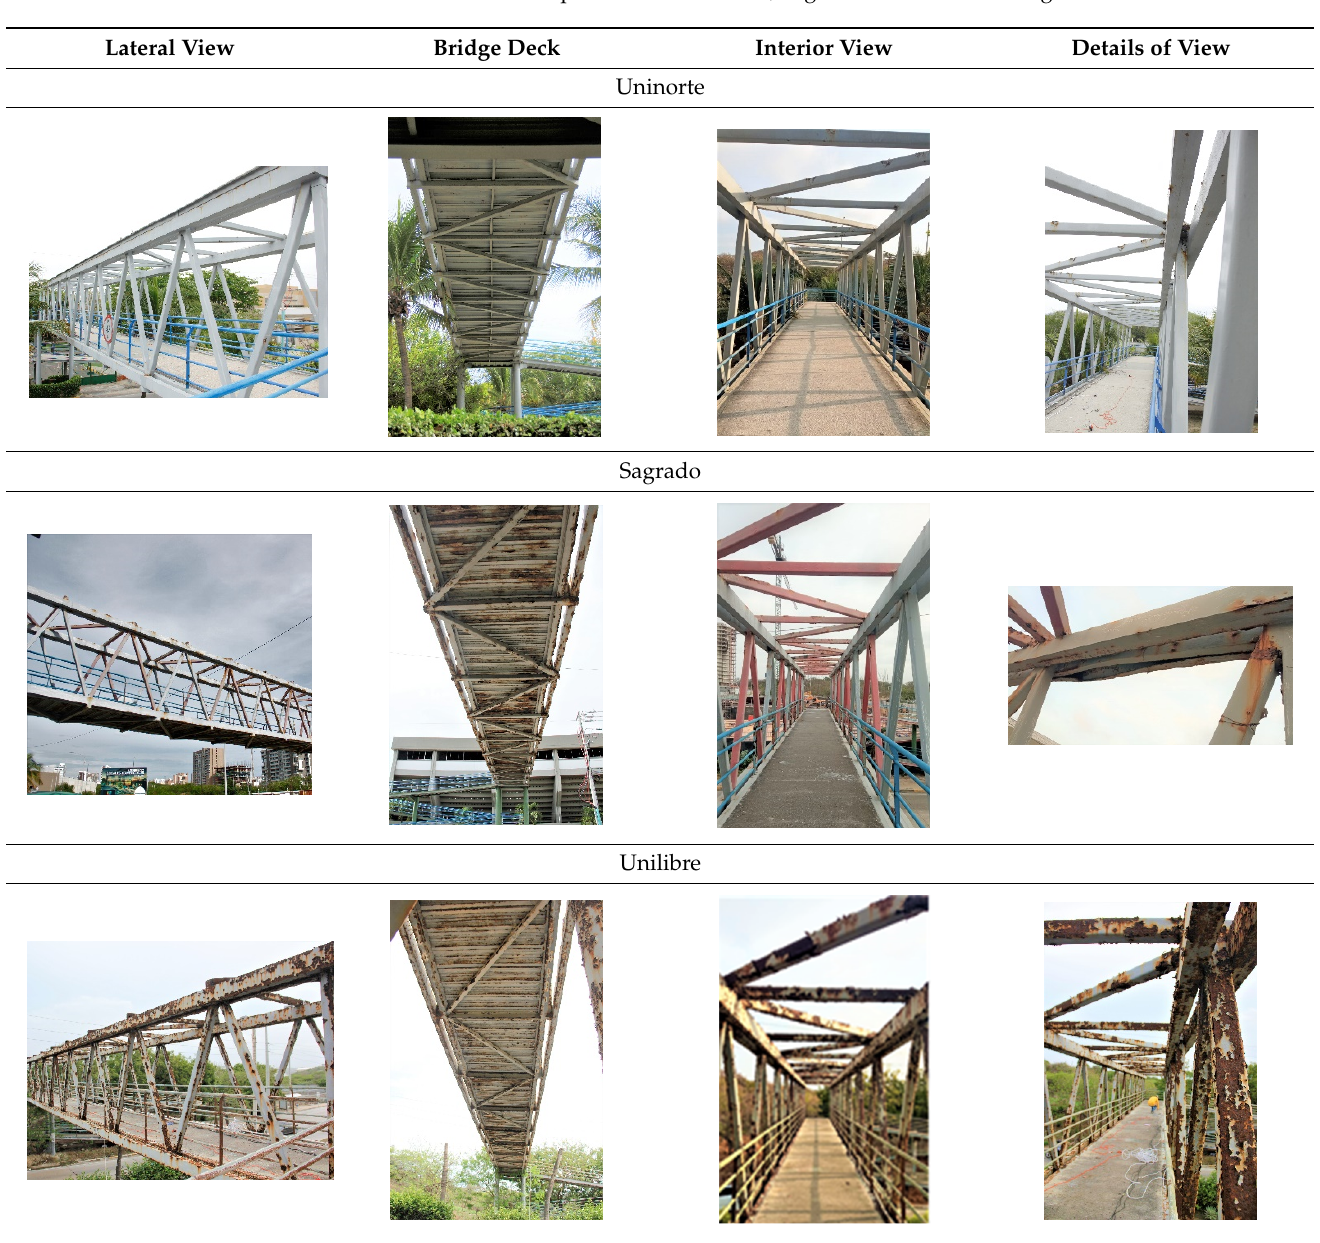
Table 1. General description of the Uninorte, Sagrado and Unilibre